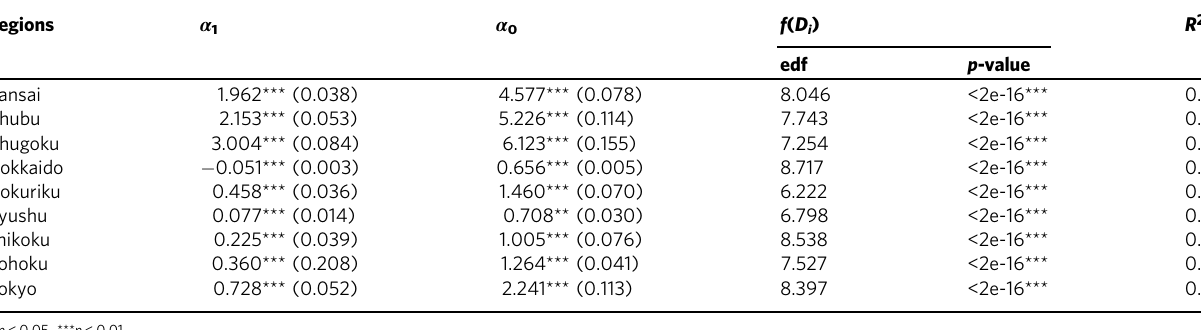
(cid:1) (cid:3) þ ε . þ α C þ f D i i 0 1